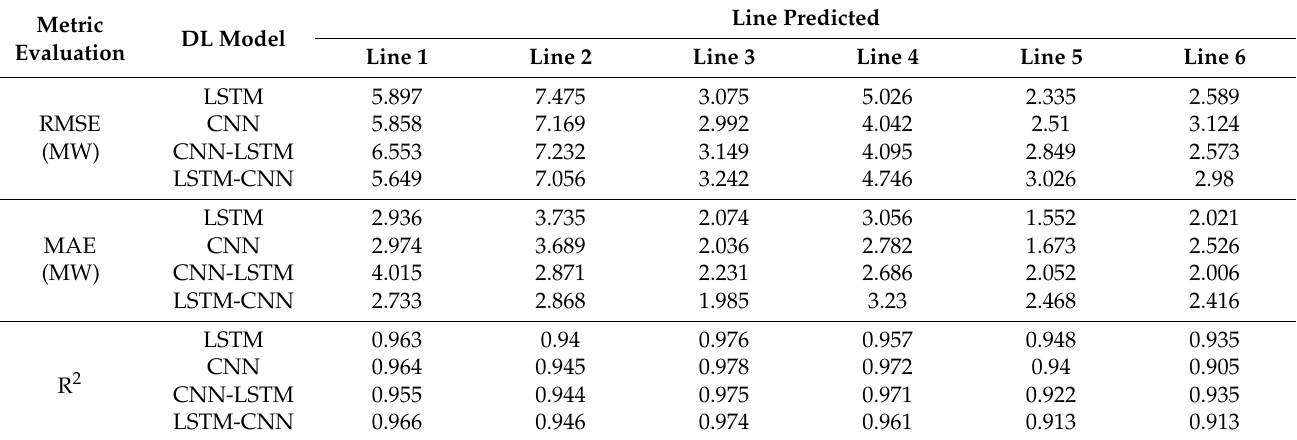
Table 8. Performance evaluation of the deep learning models based on the power flow and weather